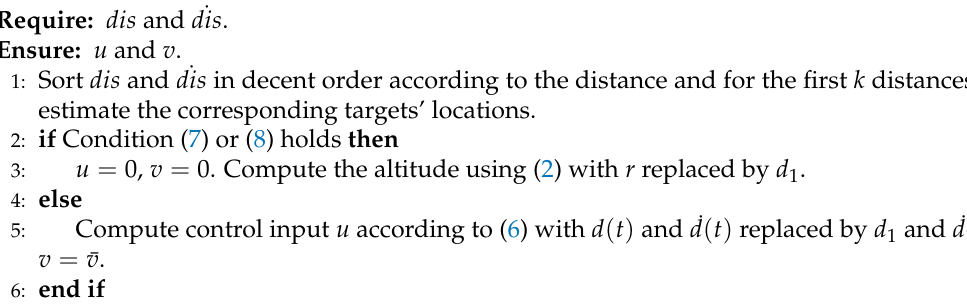
Algorithm 1 The range-based reactive navigation algorithm.